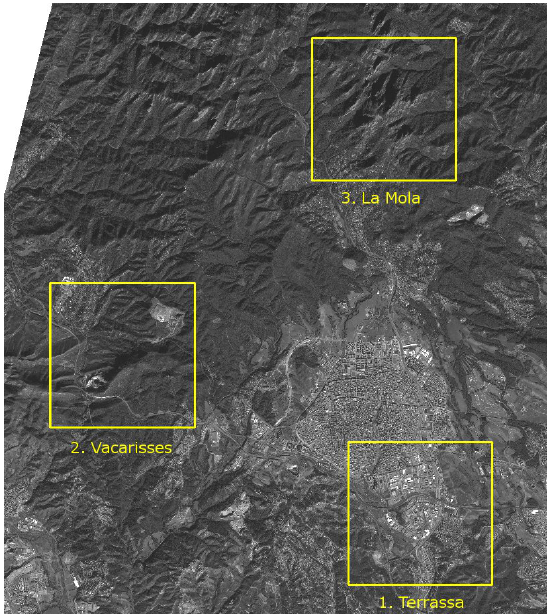
Figure 1: Cartosat-1 image showing the three 4 km × 4 km test areas: Terrassa, Vacarisses, La Mola